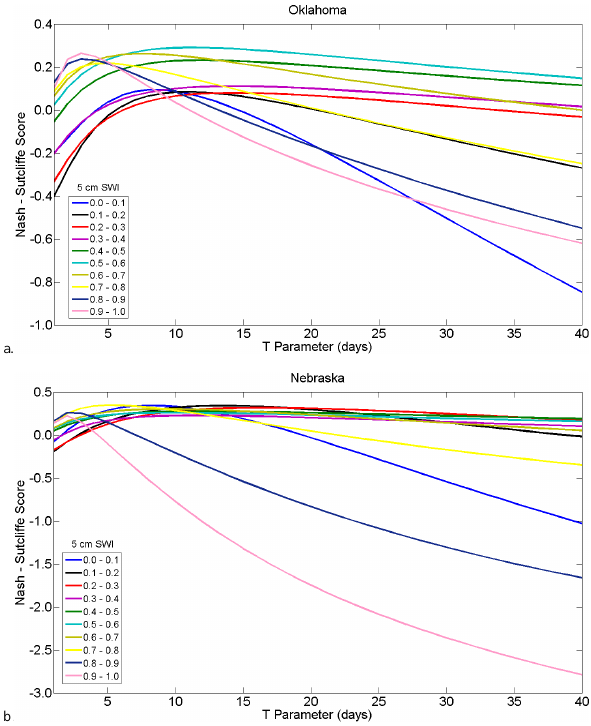
Figure 9 . Plots of the Nash-Sutcliffe score and the optimum T parameter as a function of the SWI conditions in the near-surface soil layer. Results are based on all of the (a) Oklahoma and (b) Nebraska sites.